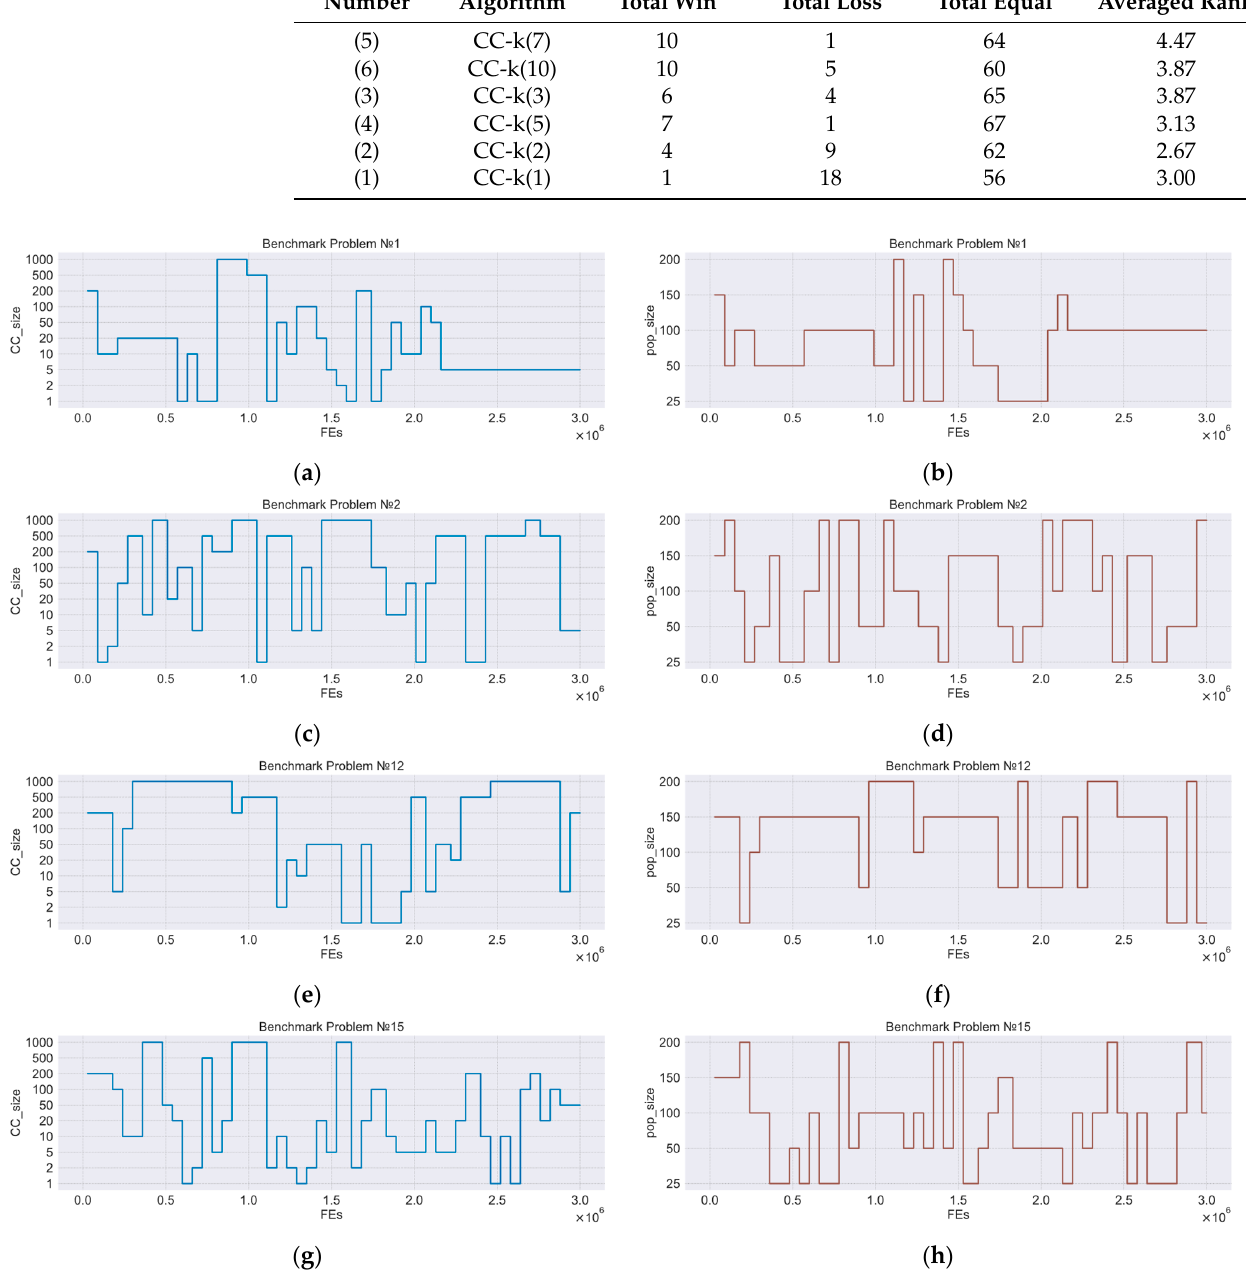
Figure 4. The self-adaptation curves for CC_size and pop_size of CC-k(7) in an independent run on: ( a , c , e , g )—CC-size for F 1 , F 2 , F 12 , F 15 and ( b , d , f , h )—pop-size for F 1 , F 2 , F 12 , F 15.